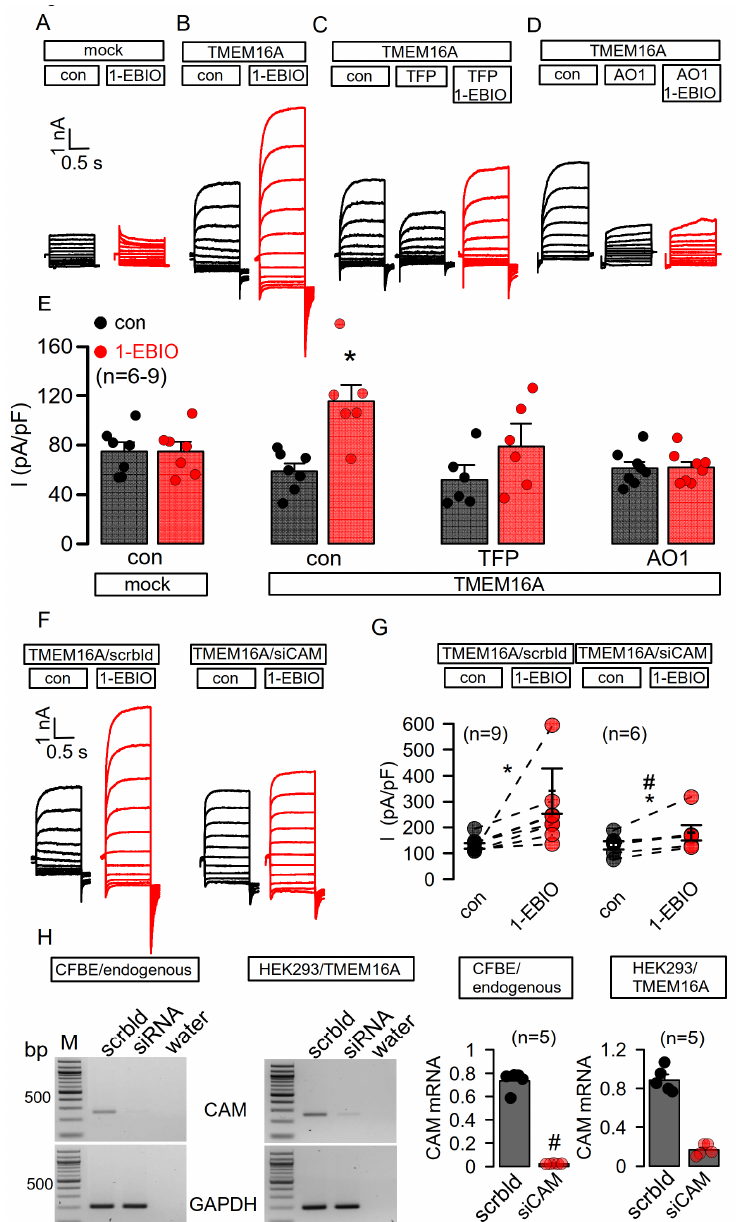
Figure 3. Enhanced Ca 2+ sensitivity of overexpressed TMEM16A is mediated by CAM. ( A – D ) No effect of 1-EBIO (1 mM) on whole cell currents in mock-transfected HEK293 cells. Basal activity of TMEM16A and further activation by 1-EBIO in TMEM16A-overexpressing HEK293 cells. Inhibition of basal TMEM16A-activity and attenuation of the effect of 1-EBIO by the CAM-inhibitor trifluoperazine (TFP, 10 µ M). Inhibition of basal TMEM16A-activity and inhibition of TMEM16A-activation by 1-EBIO using CaCC-inhAO1 (AO1, 20 µ M). ( E ) Summary of the current densities. ( F , G ) Basal activity of TMEM16A and further activation by 1-EBIO in overexpressing HEK cells treated with scrambled RNA (scrbld) or with siRNA for CAM (siCAM). ( H ) Knockdown of CAM was assessed by semiquantitative RT-PCR in both CFBE cells expressing endogenous TMEM16A and in HEK293 cells overexpressing TMEM16A. Similar number of CAM-transcripts are expressed in CFBE and HEK293 cells. Mean ± SEM (n = number of experiments). * Significant activation by 1-EBIO and inhibition by AO1 or TFP, respectively ( p < 0.05; paired t -test). # Significant difference when compared to activation in the absence of AO1, TFP, or siCAM, respectively ( p < 0.05; unpaired t